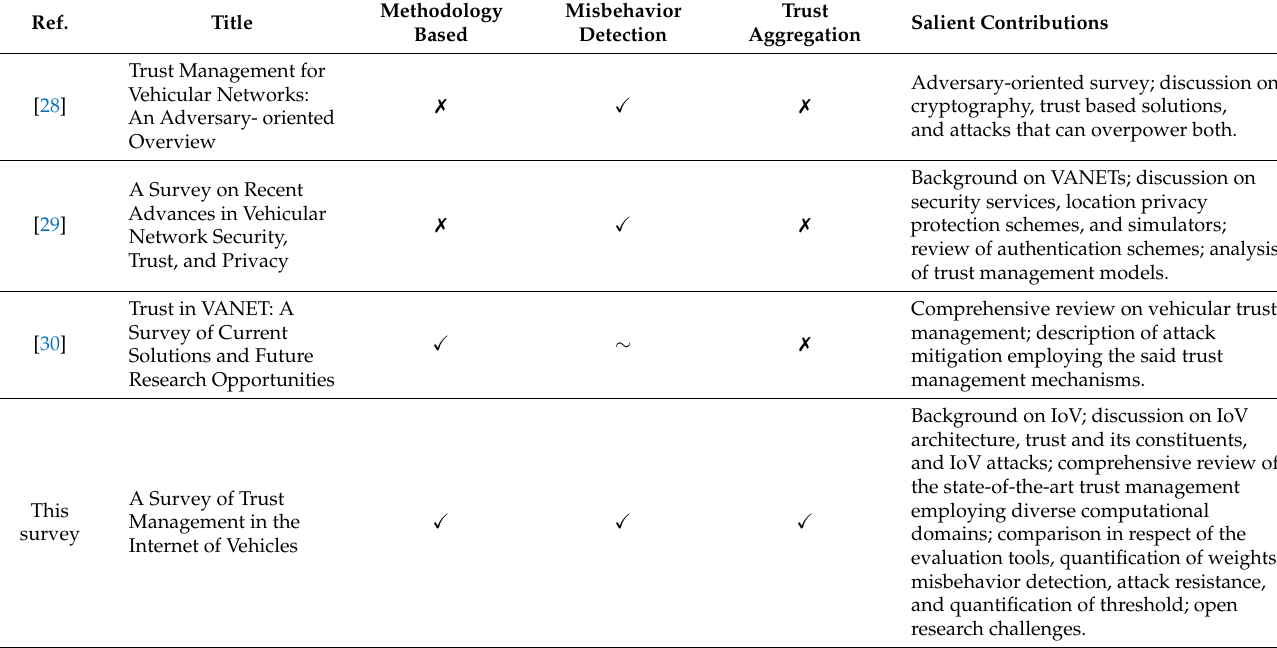
Table 1. Comparison of Recent Surveys.